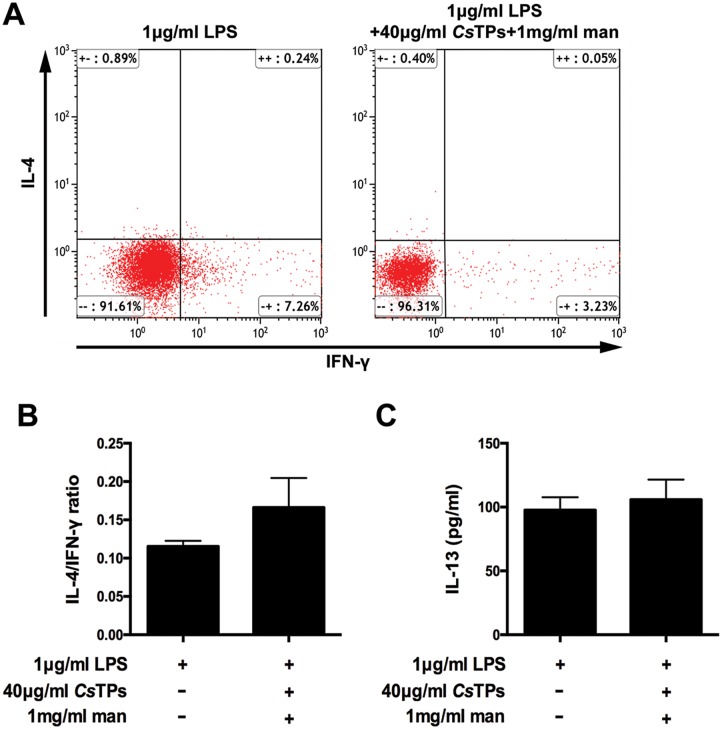
Influence of mannan as an inhibitor of MR on cytokine productions in co-culture system of BMDCs and CD4+ T cells.(A) Percentages of IL-4 positive or IFN-γ positive CD4+ T cells detected by FACS. After 30 min pre-incubation with 1 mg/ml mannan, BMDCs were stimulated with 1 μg/ml LPS and 40 μg/ml CsTPs for 24 hours. 1×104 pre-treated BMDCs were then co-cultured with 1×105 MACS-sorted CD4+ T cells for 10 d. The T cells were intracellular stained with APC-conjugated anti-IL-4 and PE-conjugated anti-IFN-γ. Representative results were shown as dot plots. (B)Statistical analysis of the ratio of single positive IL-4+ or IFN-γ+ CD4+ T cells. (C) Measurement of IL-13 Level by using ELISA. The supernatants were harvested from the above co-culture system after 10 d. IL-13 level was assayed. These results are shown as mean ± SD of three independent experiments. Statistical significance was analyzed by one-sided paired Student’s t-test (no significant difference, P>0.05 vs. LPS group).